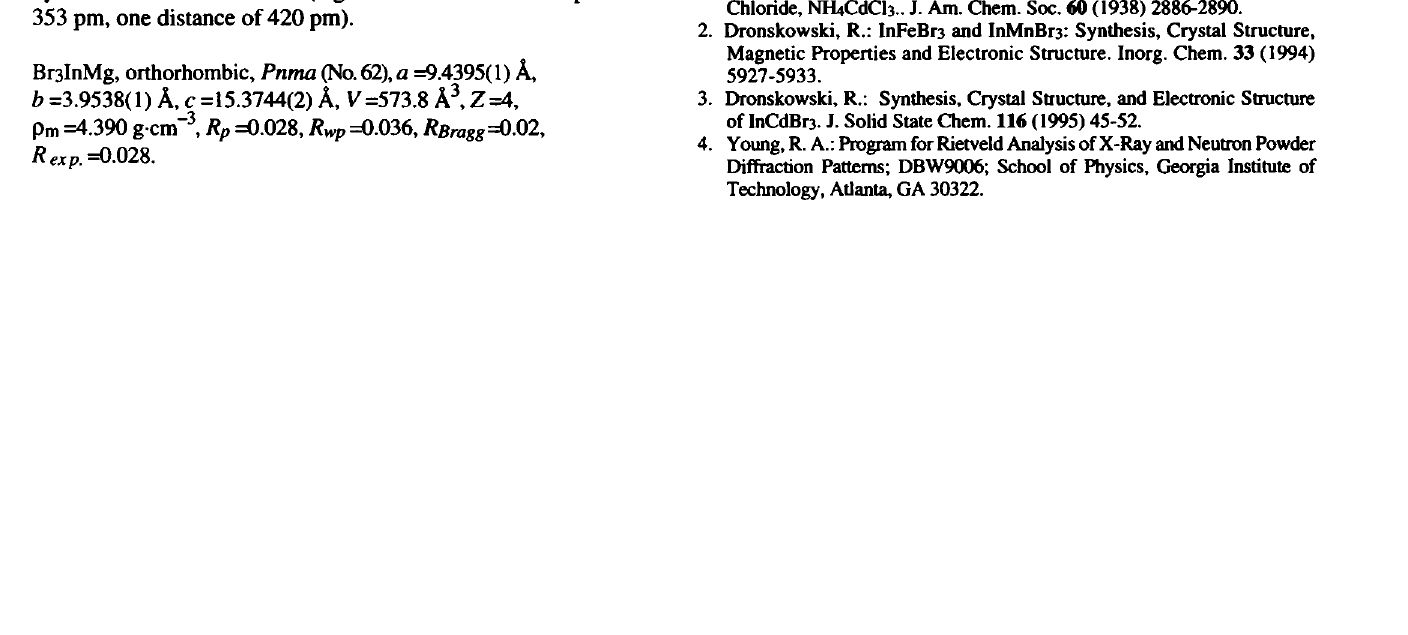
Fig. 1. [010] view with In as large shaded circles, Mg as small open circles, and Br as medium-sized black circles.